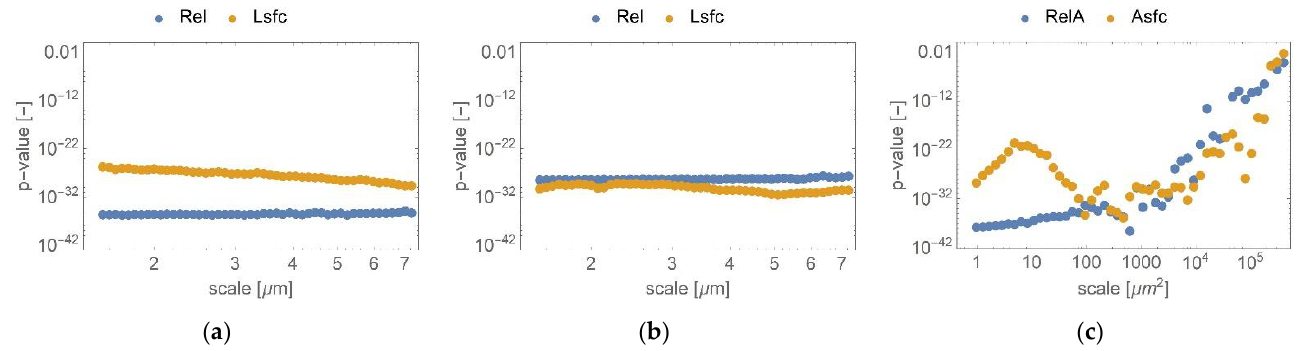
Figure 5. Results of ANOVA for discriminating against discharge energy shown as p-value as a function of scale for ( a ) length-scale analysis (rows), ( b ) length-scale analysis (columns), and ( c ) area-scale analysis.